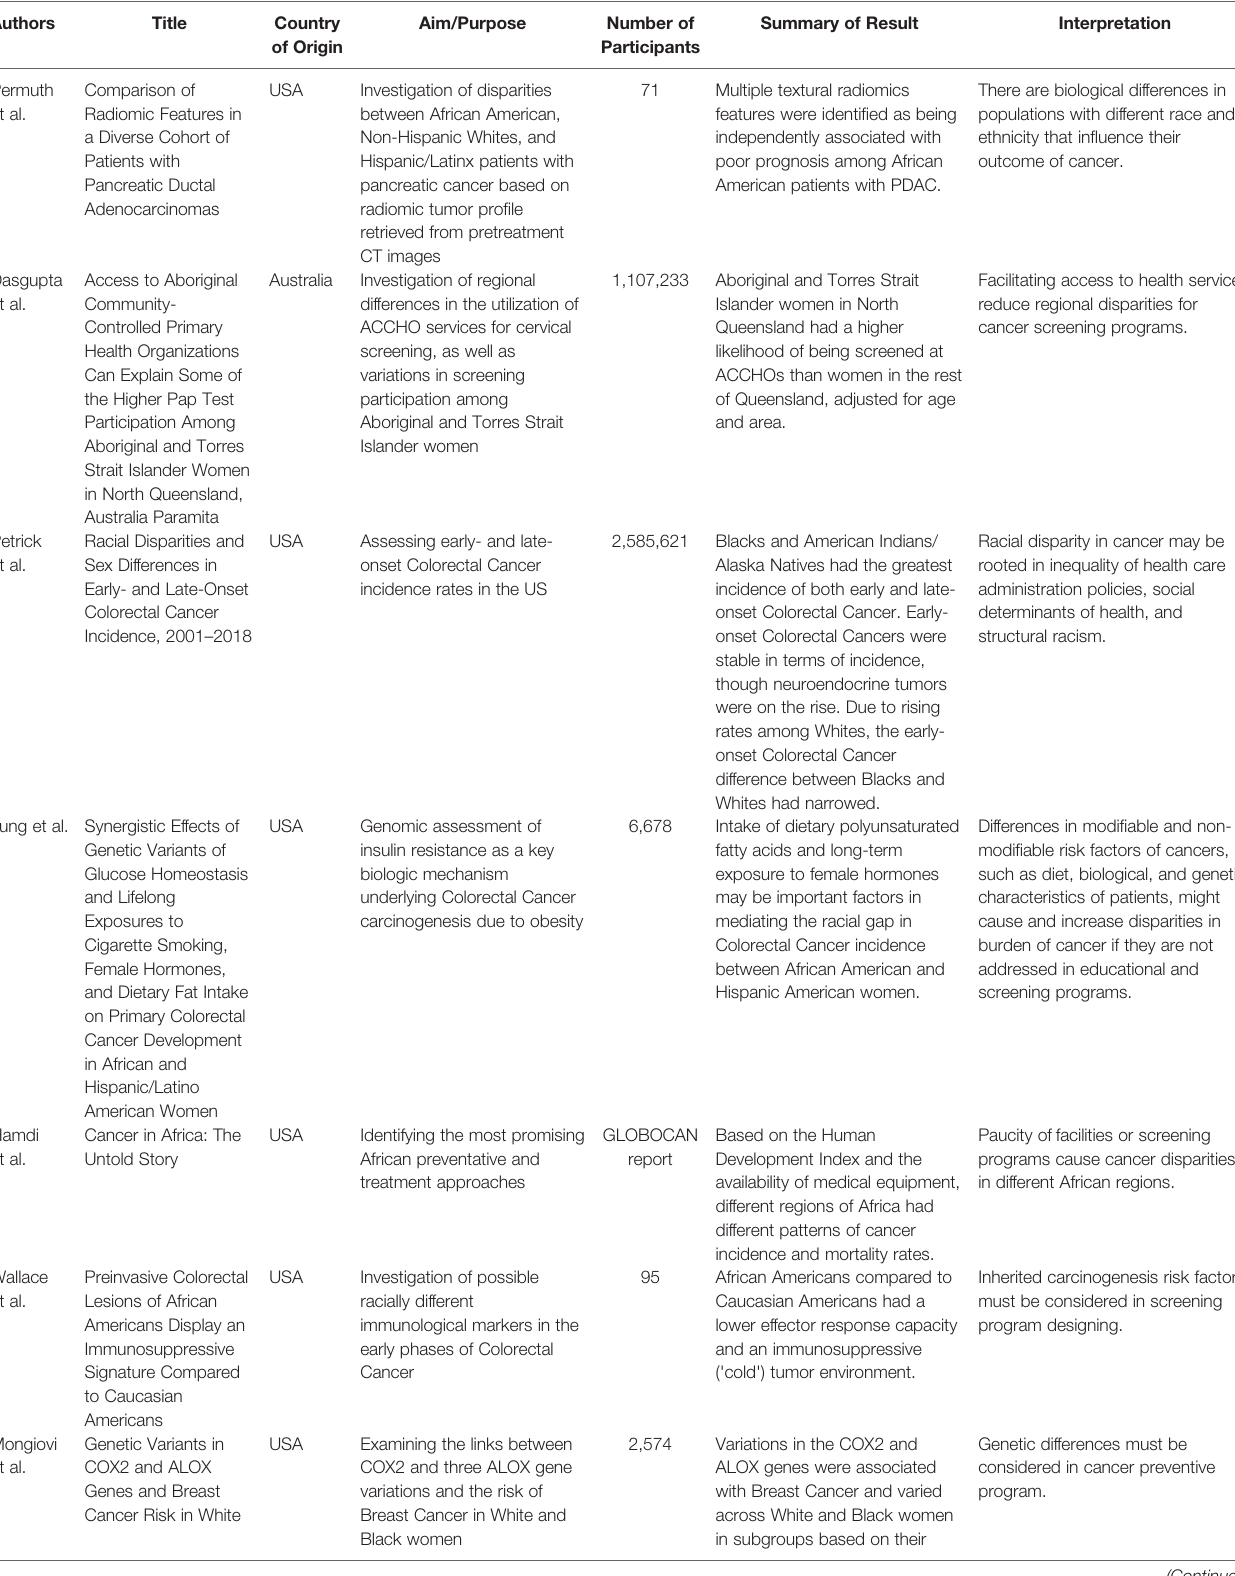
TABLE 1 | Summary of studies included in Disparities in Cancer Prevention and